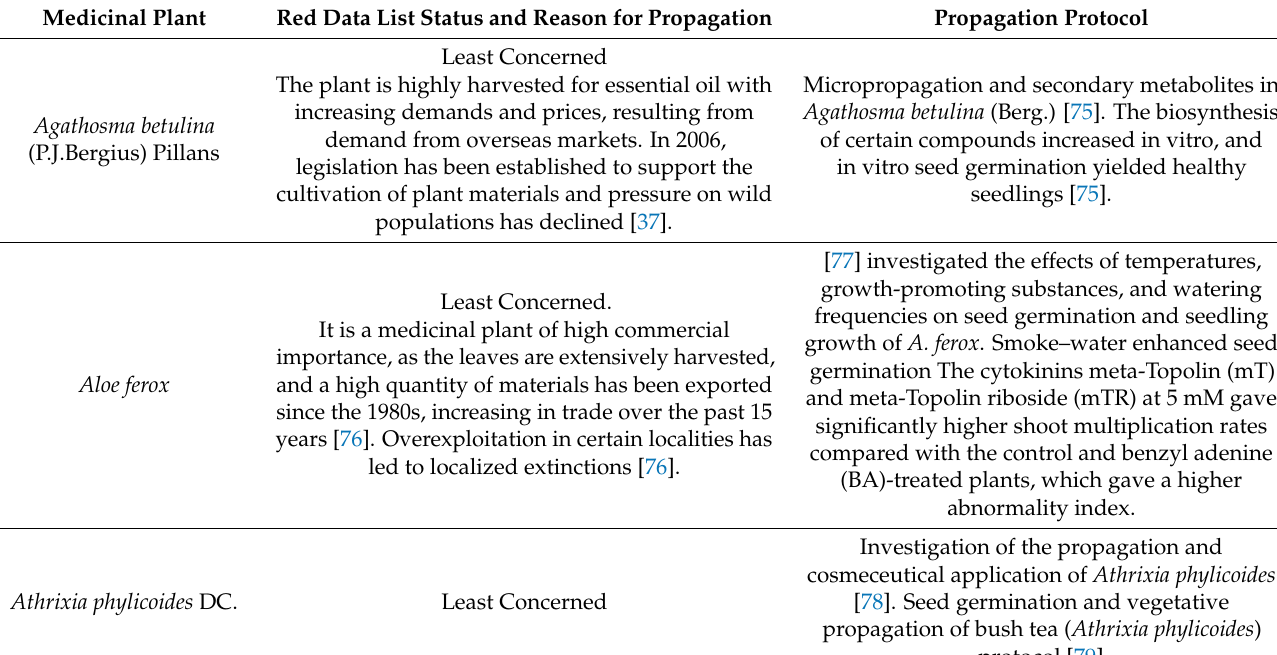
Table 1. Red data list the status of some South African indigenous and naturalized plants, reasons for their propagation, and propagation protocols available in the